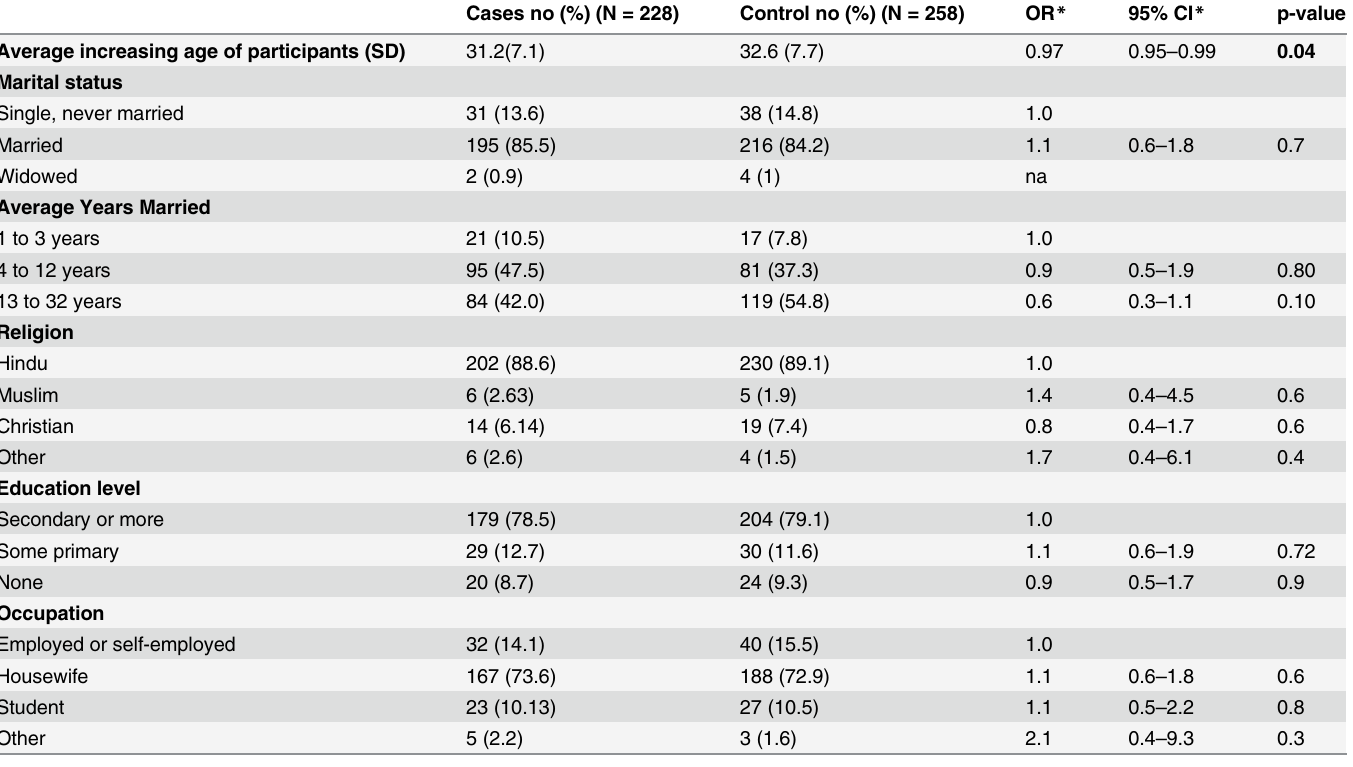
Table 1. Univariate analysis assessing association between demographics characteristic of women participating in the study according to symp- tomatic